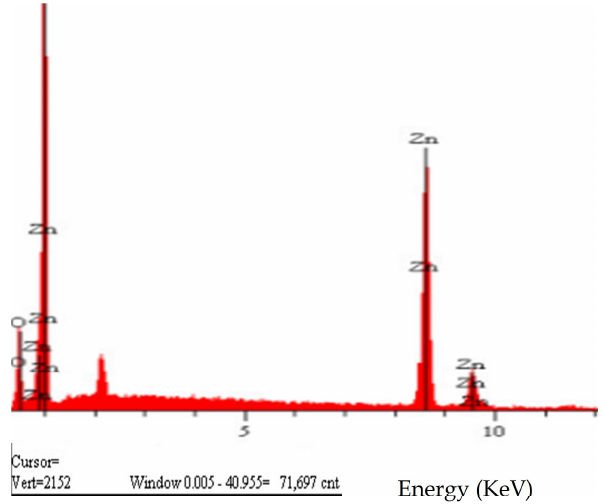
Figure 4. The results of X-ray spectroscopy (EDX) analysis of ZnO nanoparticles fixed on glass